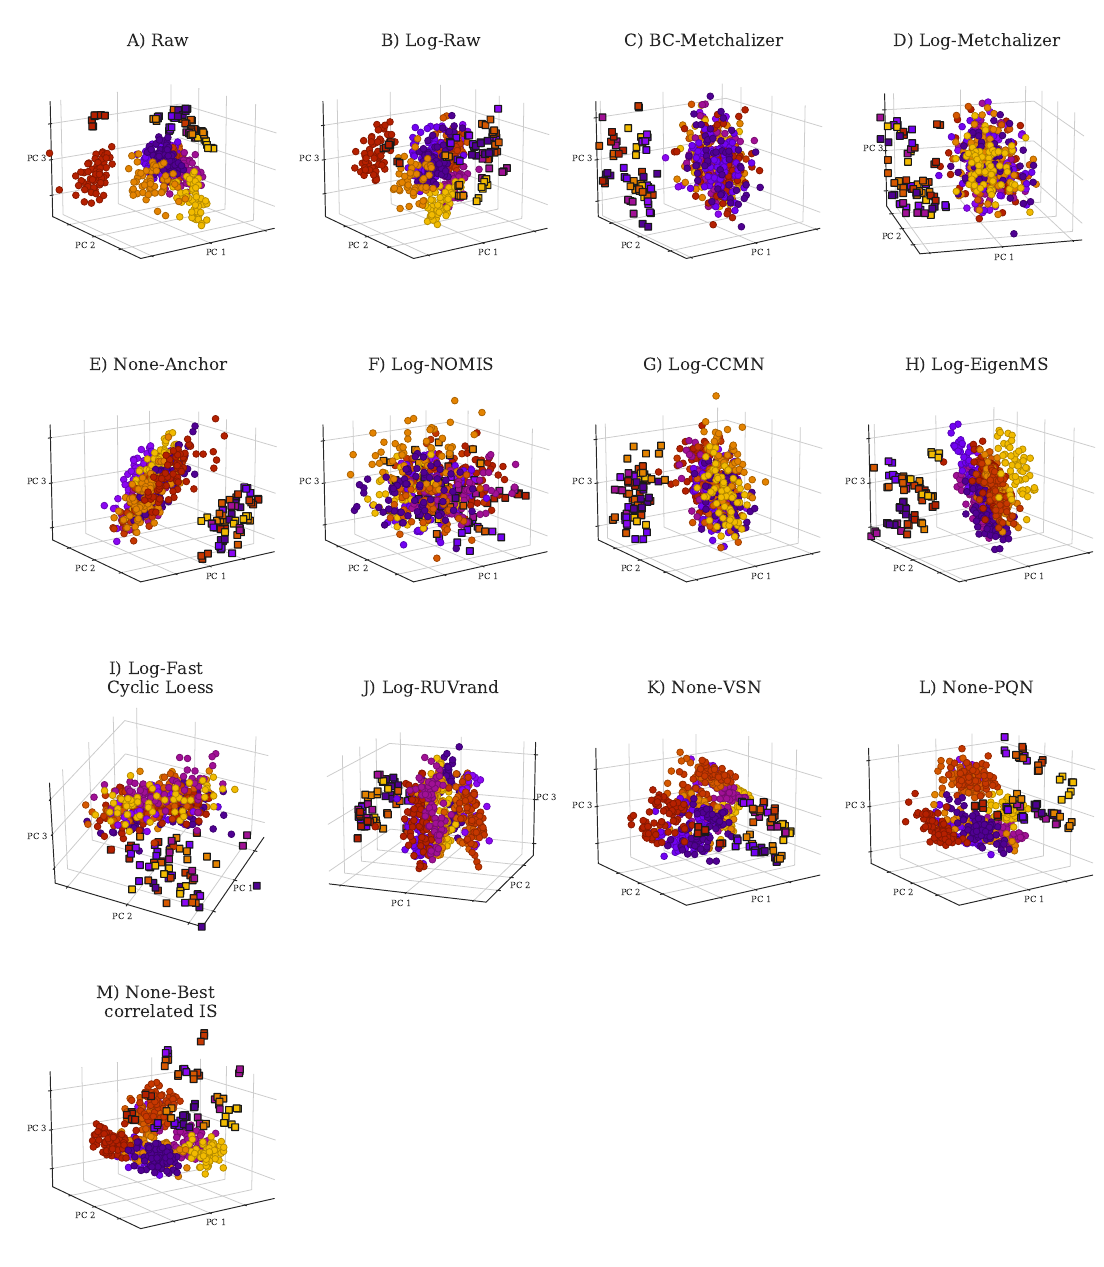
Figure 1. Principle Component Analysis (PCA) plots for raw data and normalized data as indicated by the title of each panel. Each batch is indicated with a unique color. PCA was performed on 431 features (excluding the internal and external standards) in positive ion mode. The squares indicate QC samples, whereas the circles indicate patient and control samples. ( A ) PCA plot for Raw , ( B ) Log-Raw , ( C ) BC-Metchalizer , ( D ) Log-Metchalizer , ( E ) None-Anchor , ( F ) Log-NOMIS , ( G ) Log-CCMN , ( H ) Log-EigenMS , ( I ) Log-Fast Cyclic Loess , ( J ) Log-RUVrand , ( K ) None-VSN , ( L ) None-PQN , ( M ) None-Best correlated IS